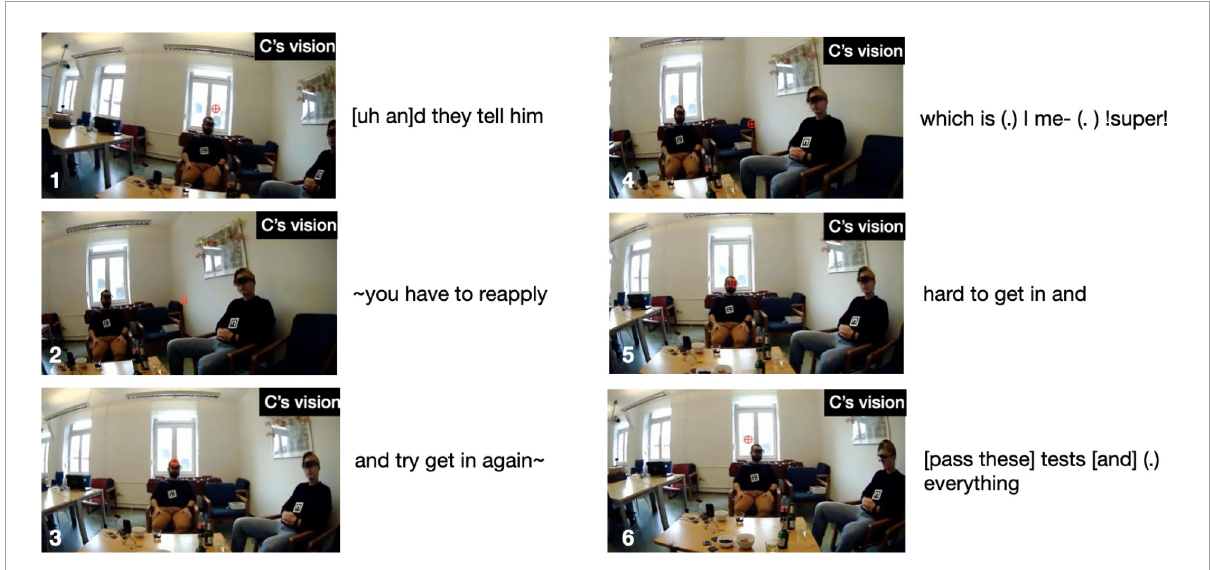
FIGURE10 Storyteller’s gaze locations at various points during the Climax in “Sad story”.